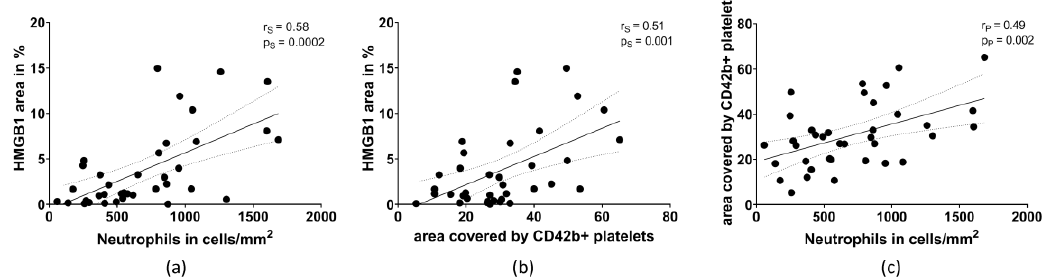
Figure 4. Correlation between ( a ) the area of HMGB1 (in % of the total thromboembolus area) and the amount of neutrophils, ( b ) the area of HMGB1 and the area covered by CD42b-positive platelets, and ( c ) the amount of neutrophils with the area covered by CD42b-positive platelets. p = level of significance. r = correlation coefficient. s = Spearman, p = Pearson.